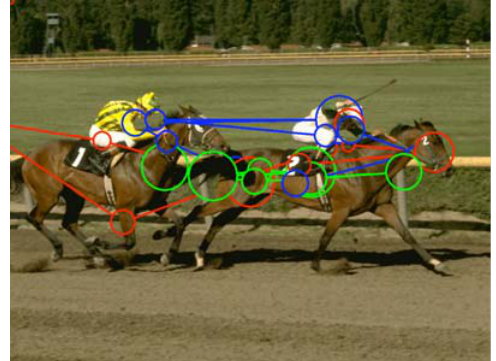
Figure 11: Example scan patterns from one participant in The Imagery First group, chosen at random. The blue scan pattern represents fixations and saccades at encod- ing; the red at imagery; and the blue at recognition. En- coding and recognition are slightly more similar than encoding and imagery or recognition and imagery. Note the increased saccadic amplitudes at